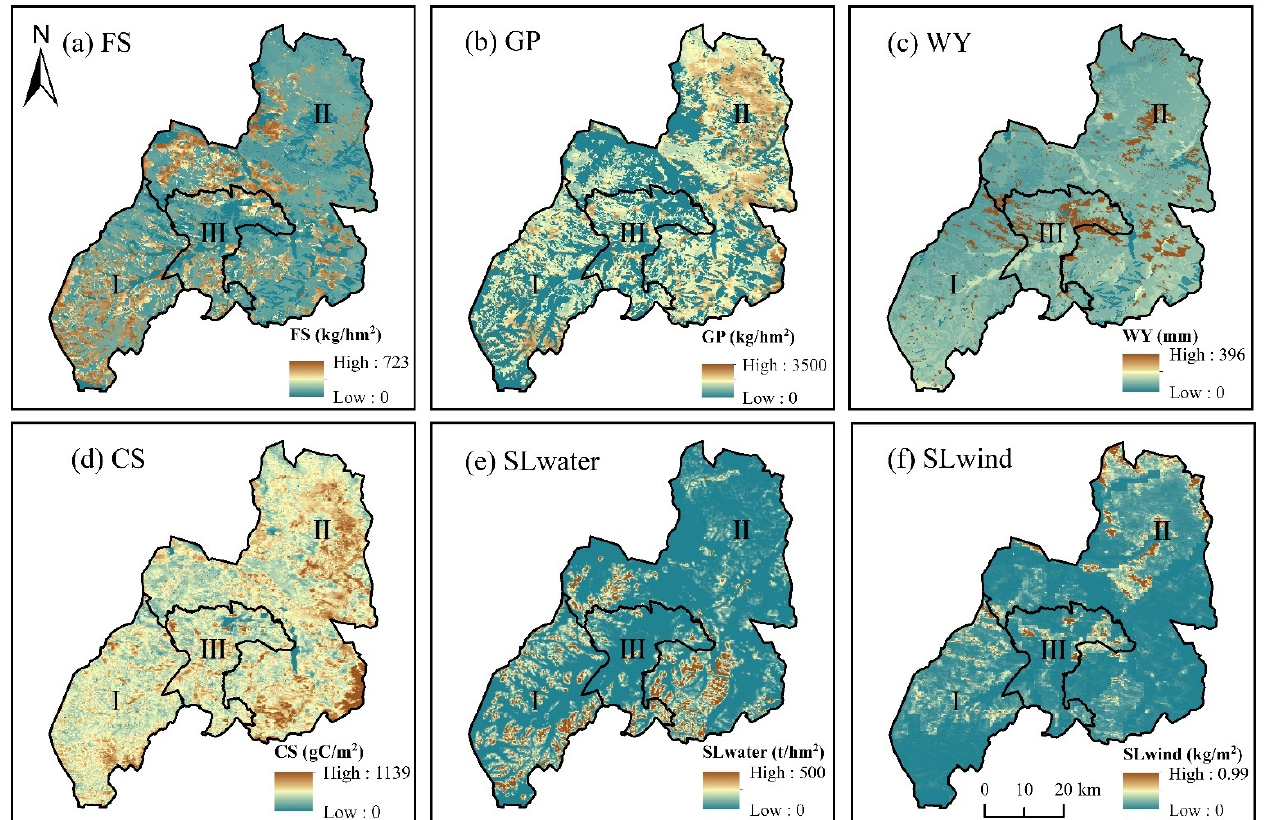
Figure 5. Spatial patterns of the six ESs in 2017. Zone I: the agricultural advantage zone (agro-zone). Zone II: the pastoral advantage zone (pastoral zone). Zone III: the semiagricultural and semipastoral zone (agro-pastoral zone). ( a ) FS: food supply (in kg/hm 2 ), ( b ) GP: grass production (in kg/hm 2 ), ( c ) WY: water yield (in mm), ( d ) CS: carbon sequestration (in gC/m 2 ), ( e ) SLwater: soil water erosion (in t/hm 2 ), and ( f ) SLwind: soil wind erosion (in kg/m 2 ).